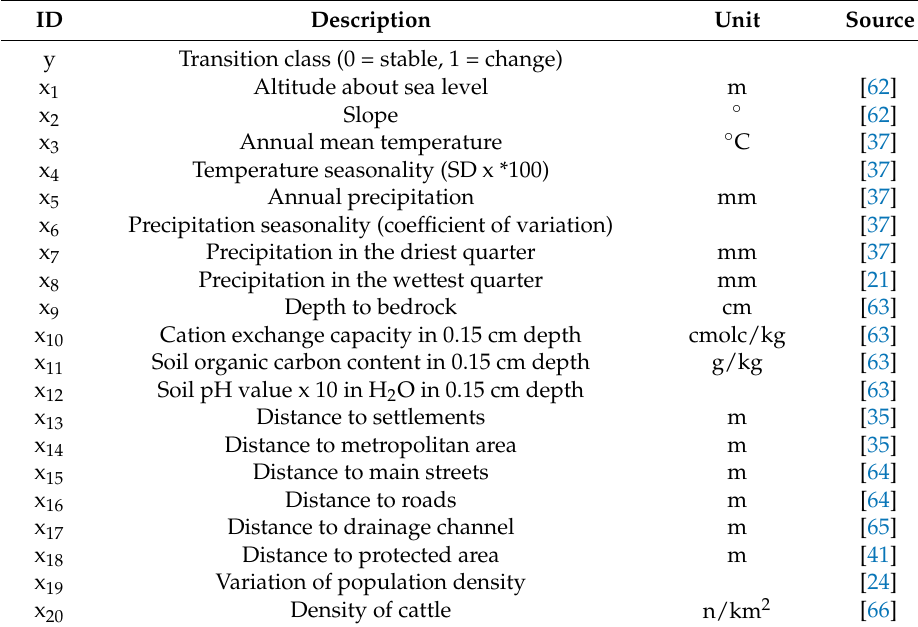
Table 4. Independent variables included in the binomial logistic regression